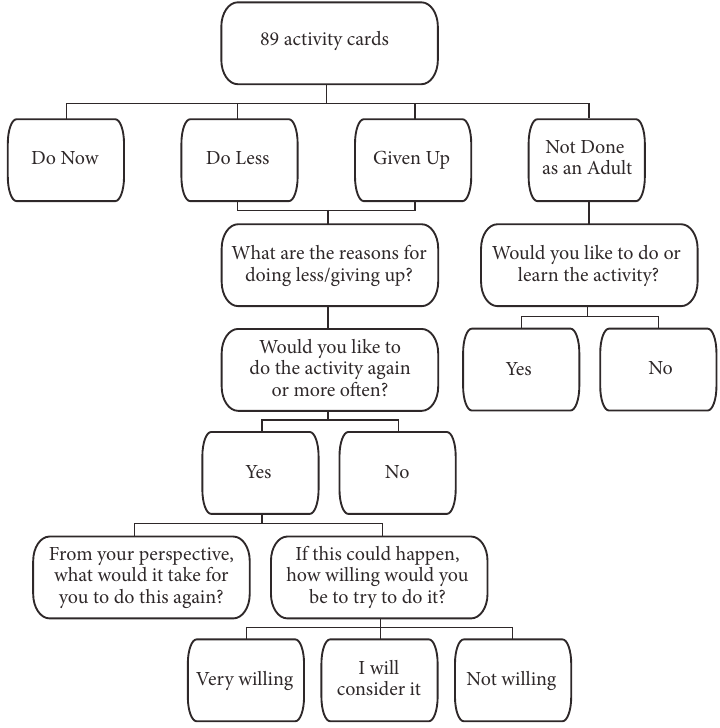
Figure 1: Flowchart of